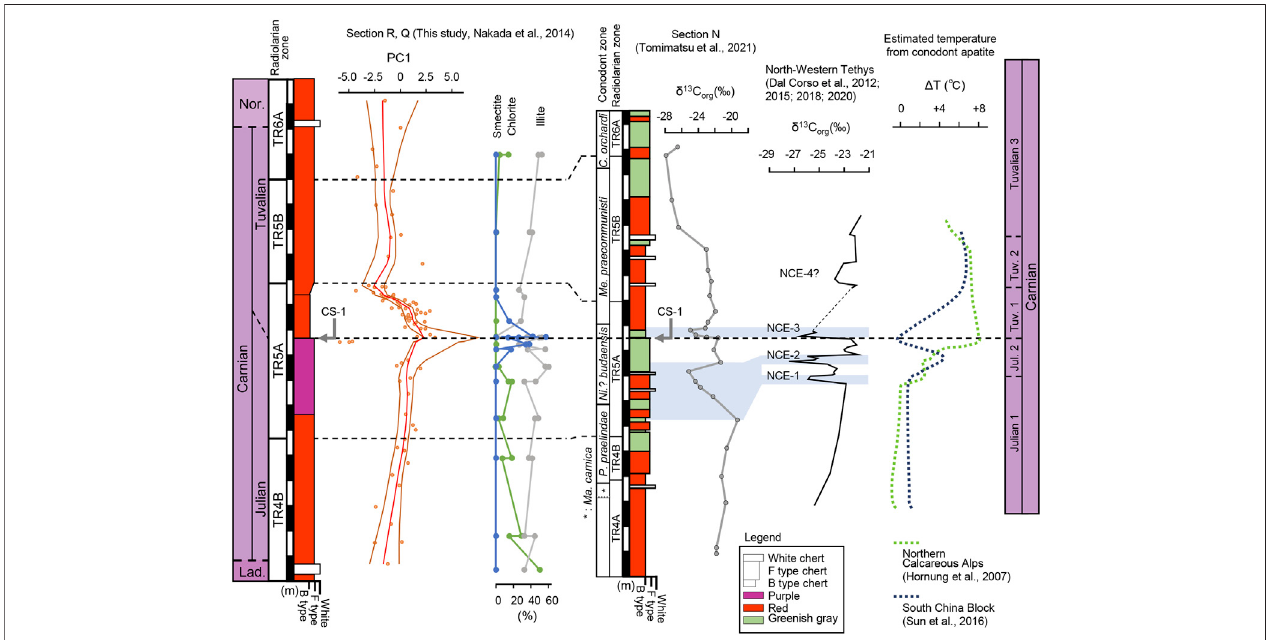
FIGURE 10 | The comparison of PC1 with compositional variation of Fe-bearing minerals and paleotemperature across the CPE. The occurrence of smectite (Nakada et al., 2014) overlaps with the high PC1 interval. Section R and Section N of Inuyama area are correlated by radiolarian biozone and CS-1 as a key bed (Sugiyama, 1997). The conodont and carbon isotope correlations are based on Dal Corso et al. (2020) and Tomimatsu et al. (2021). Paleotemperature pro fi les are calculated from oxygen isotopeof conodont apatite from the western Tethys and the South China Block (Hornung et al., 2007; Sun et al., 2016; redrawn from; Dal Corso et al.,